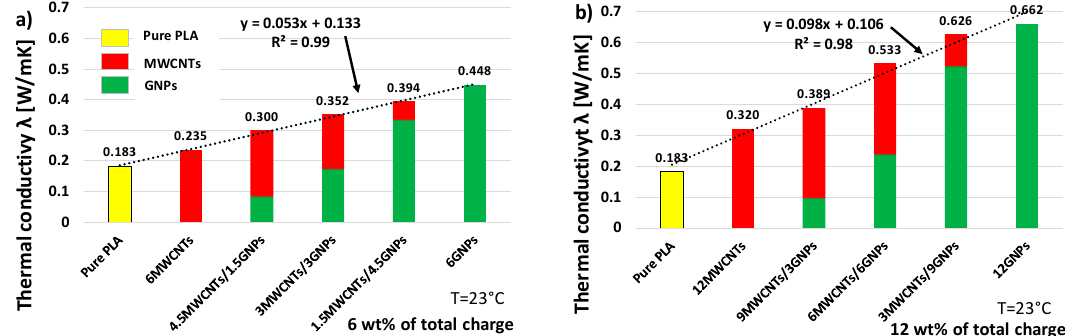
Figure 20. Thermal conductivity for printed samples of pure PLA and PLA filled with 6 wt % and 12 wt % of total amount in ( a ) and ( b ), respectively.